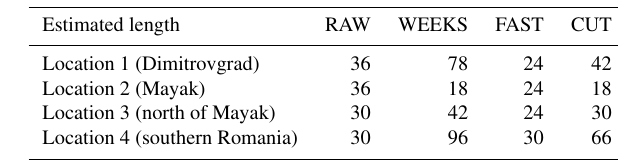
Table 4. Estimated length of non-zero activity (higher than 1TBq in a period of 6h) of source terms in hours for a specific dataset (columns) and for a specific location